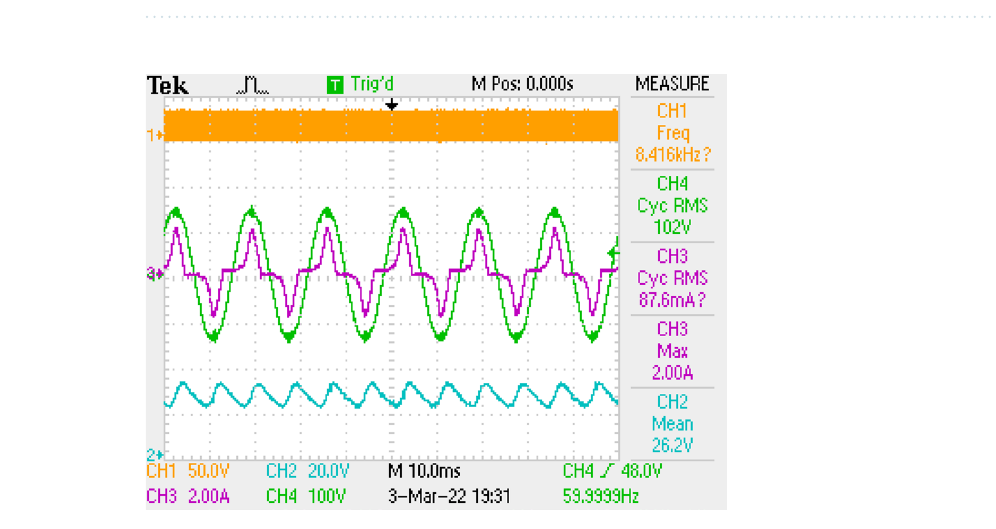
Figure 23. By LCL DM filter, THD of grid current.